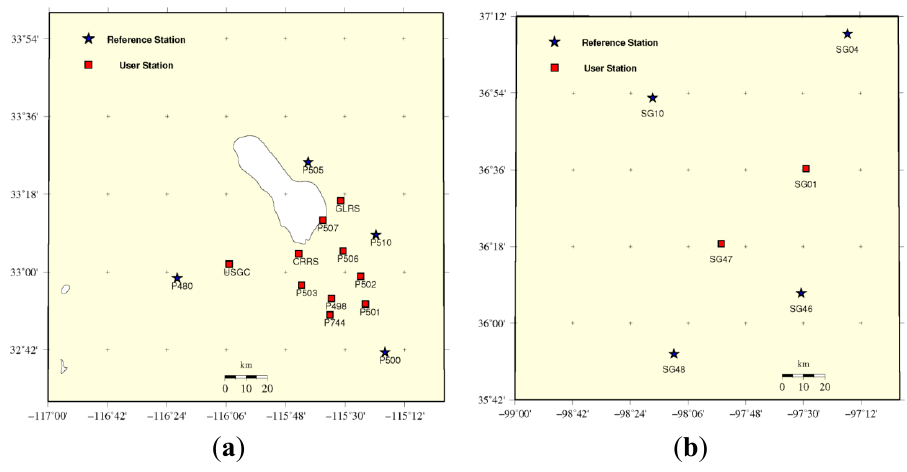
Figure 2. Medium ( a ) and long ( b ) inter-station distance reference network, the red square-user station, blue star-reference station.